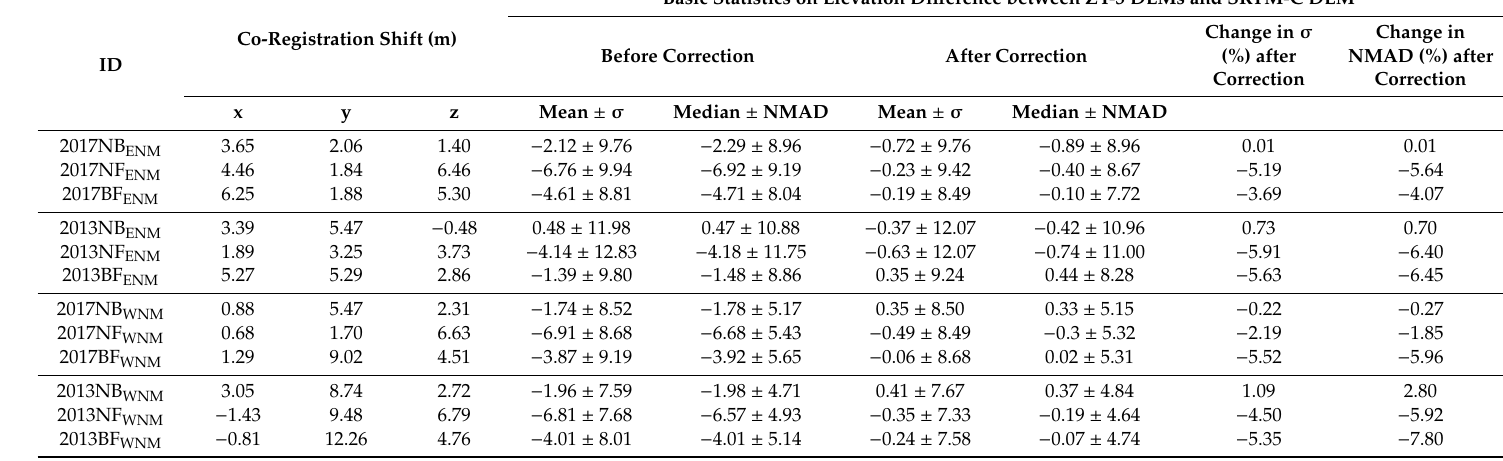
Table 3. Co-registration shifts of the ZY-3 DEMs with respect to the SRTM-C DEM and statistics on elevation di ff erence (dh) between ZY-3 DEMs and the SRTM-C DEM in o ff -glacier samples with and without correction using co-registration; σ and Normalized Median Absolute Deviation (NMAD) are the standard deviation and normalized median absolute deviation of the elevation di ff erence (dh),